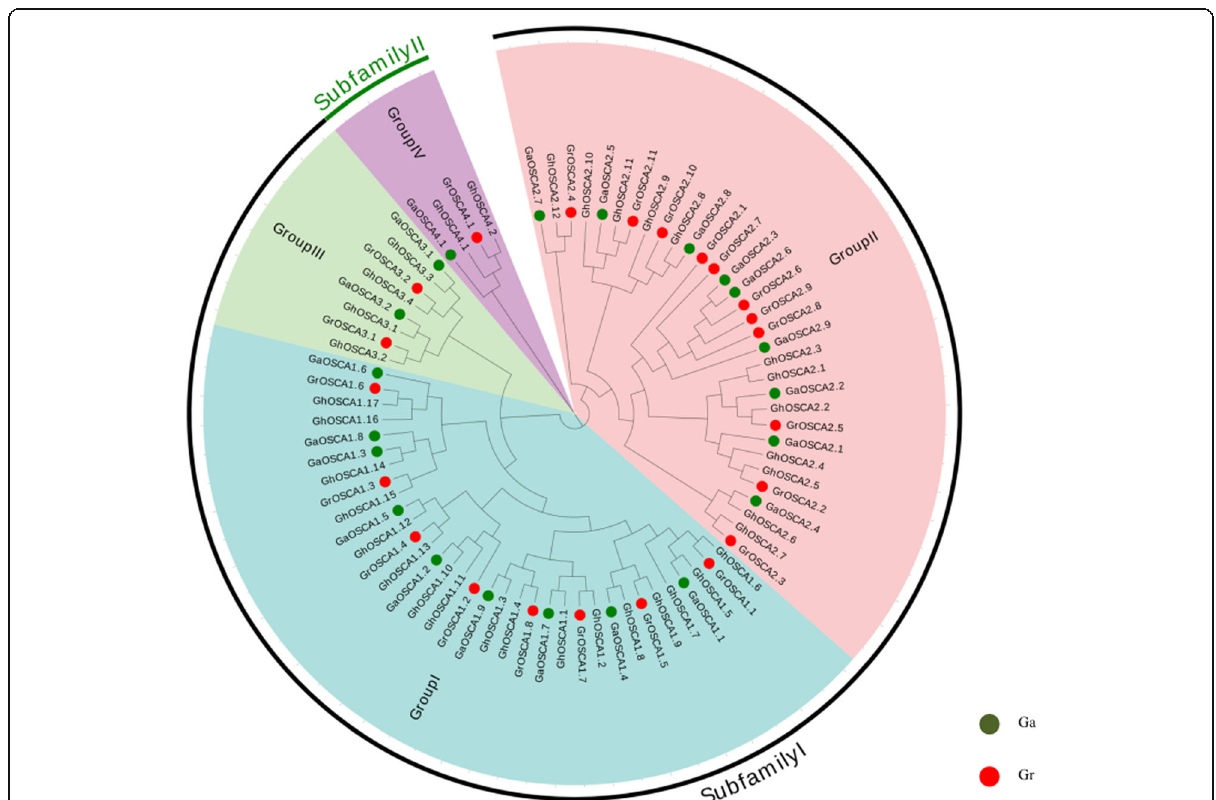
Fig. 2 Phylogenetic analysis of OSCA proteins in G. hirsutum , G. arboreum and G. raimondii . Ga: Gossypium arboreum ; Gr: Gossypium hirsutum